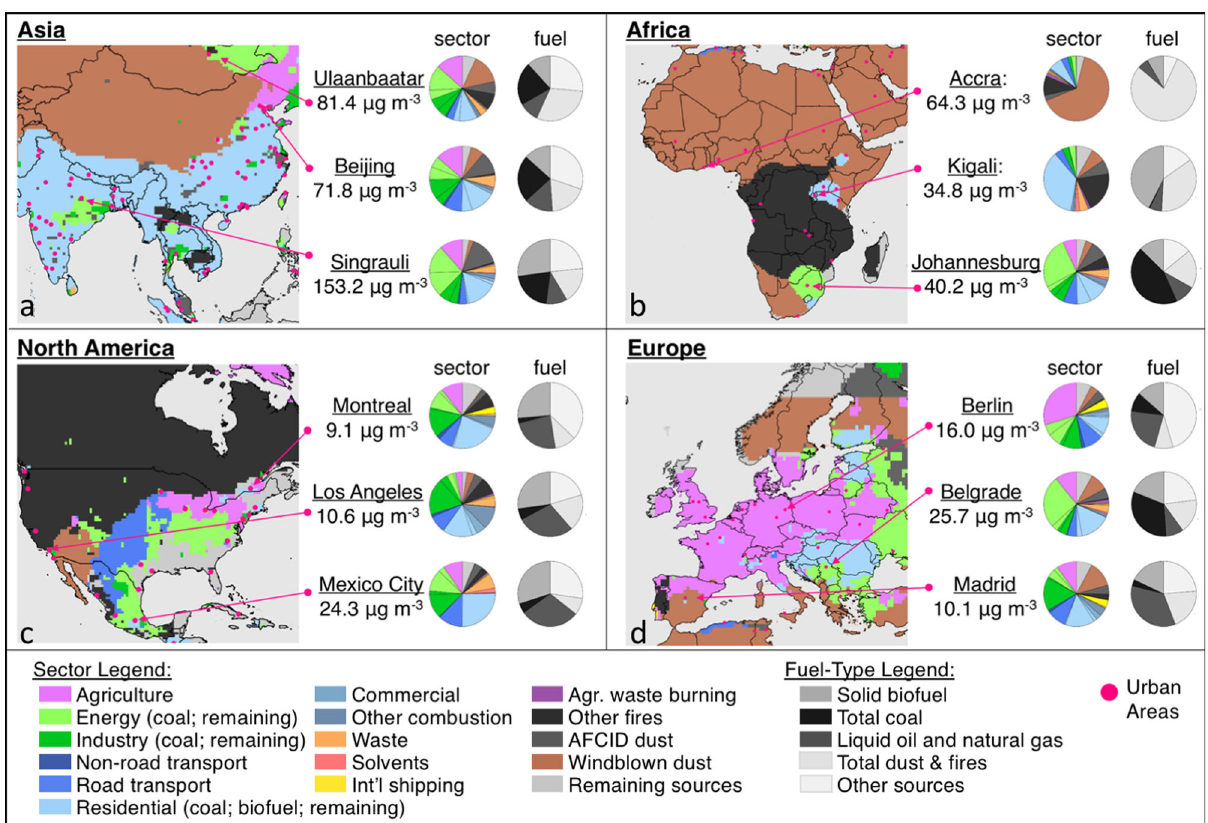
Fig. 5 Sub-national sources of PM 2.5 mass and attributable mortality. Results are shown for ( a ) Asia, ( b ) Africa, ( c ) North America, and ( d ) Europe. Maps illustrate the single source with the largest contribution in each model grid cell (0.5° × 0.625°). Population-weighted mean PM 2.5 concentrations (calculated from 0.01° × 0.01° PM 2.5 exposure estimates) and regional fractional source contributions are also shown for a select sub-set of sub-national regions, identi fi ed by the name of the nearest major